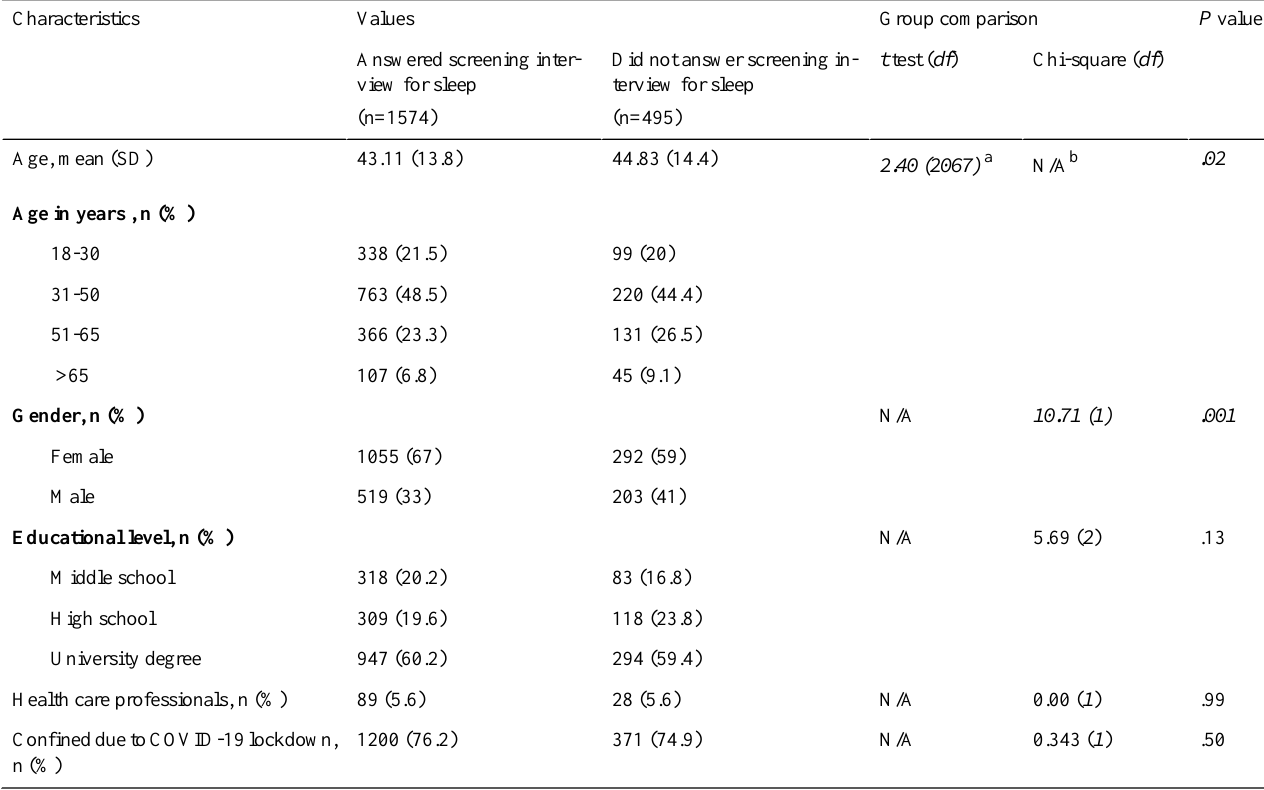
Table 1. Characteristics of KANOPEE users depending on their use of the app.